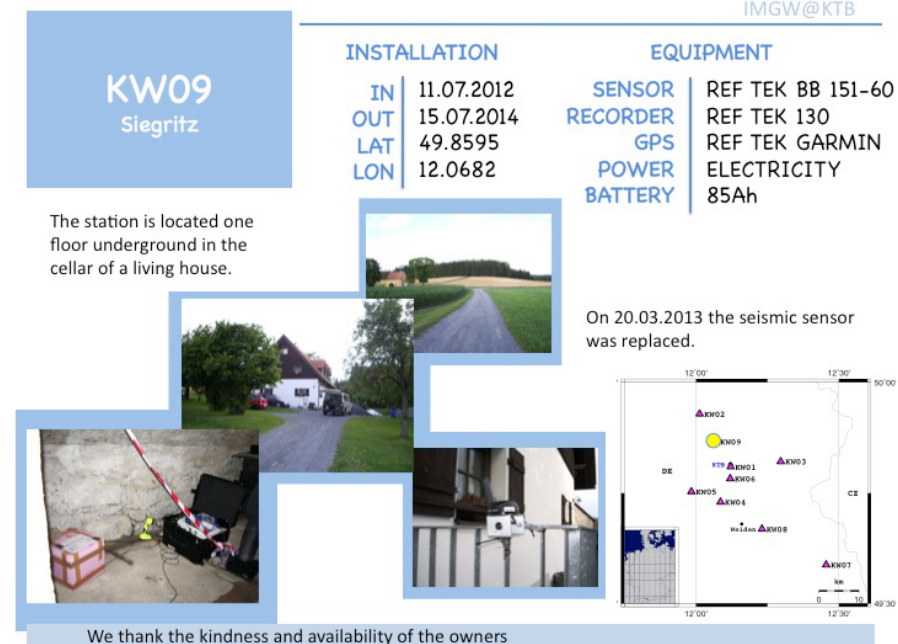
2 Figure A9. Station KW09 technical